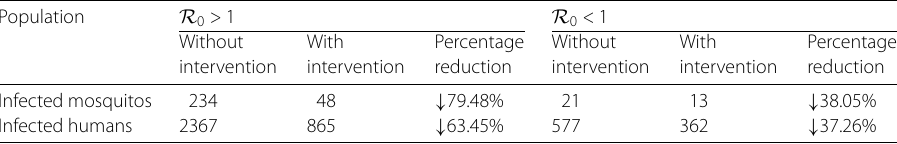
Table 3 Number of infected individuals on day 500 in the cases of R 0 < 1 and R 0 > 1 Population R 0 > 1 R 0 < 1 Without With Percentage Without With Percentage intervention intervention reduction intervention intervention reduction Infected mosquitos 234 48 ↓ 79.48% 21 13 ↓ 38.05% Infected humans 2367 865 ↓ 63.45% 577 362 ↓